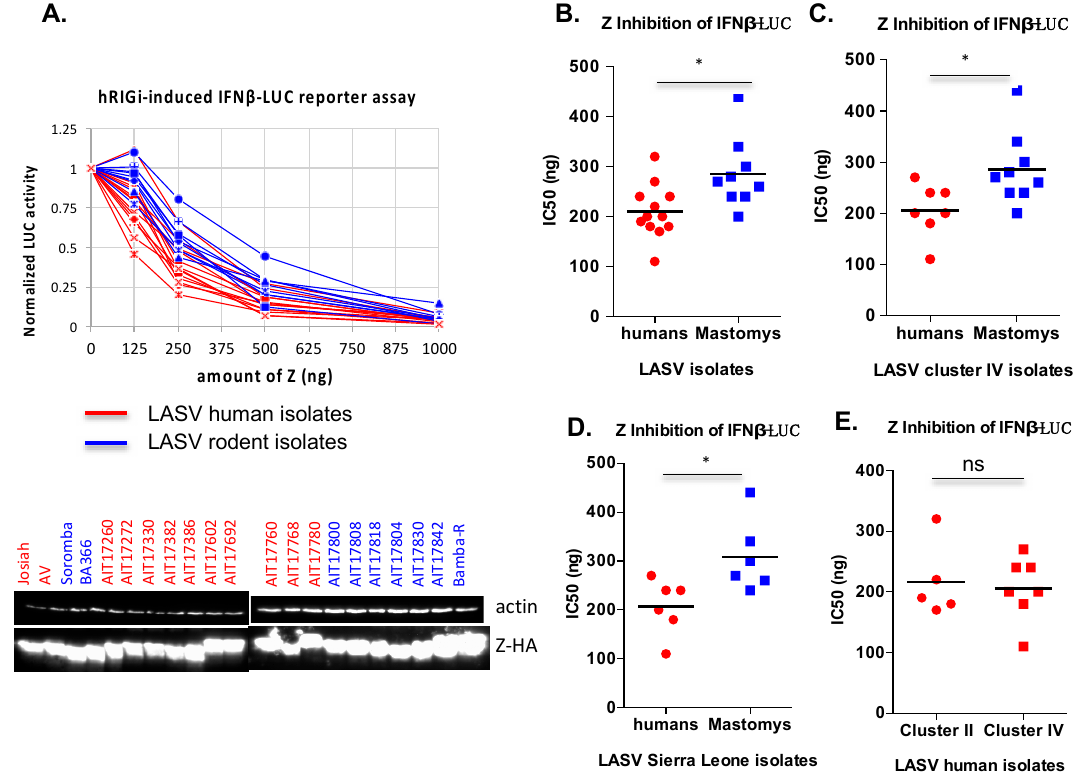
Figure 3. Comparative hRIG-I inhibitory analysis of Z proteins from di ff erent LASV isolates. The hRIG-I inhibitory e ff ects by the respective Z proteins (in a dose-dependent manner) were determined as described above in the Figure 2 legend. ( A ) The normalized LUC activity by the empty vector control is shown for each Z protein in di ff erent doses. Western blot analysis of the tested LASV Z proteins is shown, with those from human viral isolates in red and those from rodent viral isolates in blue. Notable di ff erences in the size of the Z proteins correspond to di ff erences in their primary amino acid sequences. IC 50 values were determined by the amount of the Z plasmid required to reduce the LUC reporter activity by 50% and are compared between Z proteins of human and rodent viral isolates ( B ), between Z proteins of human and rodent viral isolates within the same cluster IV ( C ), between Z proteins of human and rodent viral isolates within the same country (Sierra Leone) ( D ), and between Z proteins of human viral isolates between clusters II and IV ( E ). Each plasmid transfection experiment was conducted in triplicate and repeated in at least two independent experiments. Statistical significance between two groups was determined using the two-tail unpaired Student’s t -test of GraphPad Prism 6 software. Statistical significance: ns, not significant; *, p <